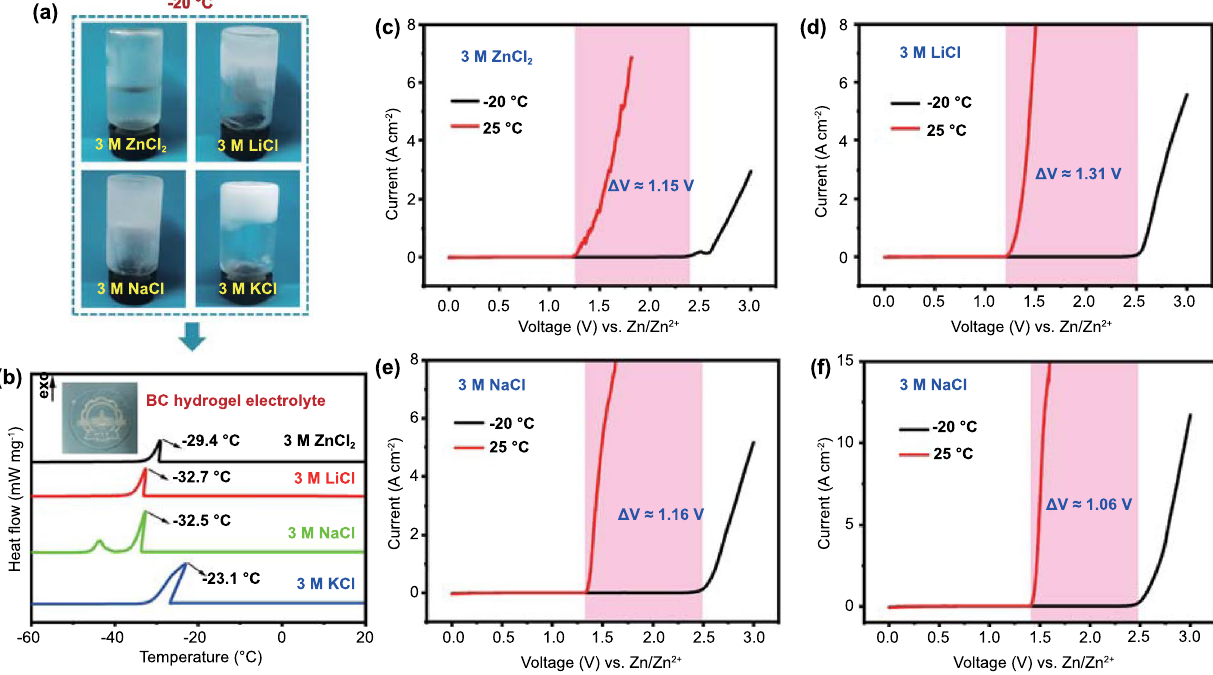
Fig. 2 a Optical photographs of four chloride aqueous solutions at -20 °C. b DSC curves of the corresponding hydrogel electrolytes. The inset is the optical image of 3 M ZnCl 2 hydrogel electrolyte. The electrochemical windows of hydrogel electrolytes containing c 3 M ZnCl 2 , d 3 M LiCl, e 3 M NaCl, and f 3 M KCl at 25 °C and −20